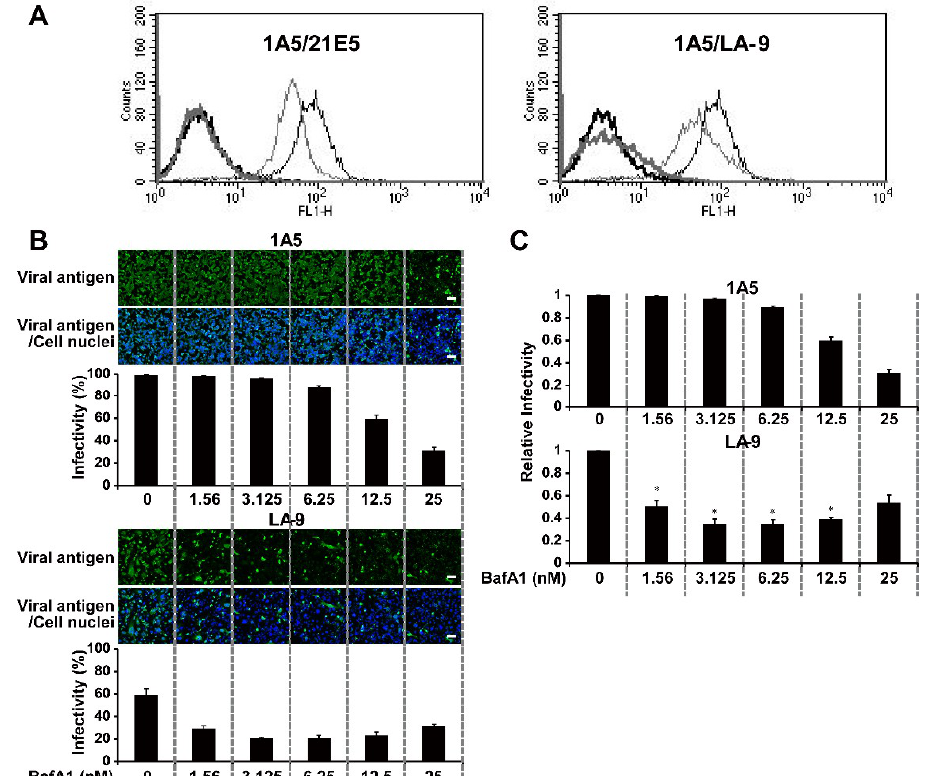
Figure 4. pH levels in acidic compartments within human small airway epithelial cell clones and human tracheal epithelial cell clones. ( A ) Human SAEC-T clone 1A5 and HTEpC-T clone LA-9 were stained with LysoSensor Green DND-189 and then analyzed by flow cytometry. The profiles of the stained cells are shown as black (1A5) and gray (21E5 and LA-9) lines. The profile of 1A5 cells is the same in the left and right panels. Control cells (no staining) are denoted by bold lines. ( B ) Human SAEC-T clone 1A5 and HTEpC-T clone LA-9 were treated with bafilomycinA1 (BafA1; 0–25 nM) for 2 h and then infected with Cw / Ky (H5N1) at an m.o.i. of 10. Twelve hours later, infectivity was determined by calculating the percentage of antigen-positive cells (as described in Figure 1). Representative micrographs of antigen-positive cells treated with BafA1 are shown. Cell nuclei were also counted. Viral infectivity was determined as described in Figure 1. Data are expressed as the mean ± SD of three independent results. Scale bars, 100 µ m. ( C ) Summary of relative infectivity in panel ( B ). The infectivity in the absence of reagent was set to 1. Asterisks indicate an infectivity ratio that was significantly lower than that for 1A5 cells at the same concentration of reagent. A p -value < 0.01 (asterisk) was considered significant (Student’s t